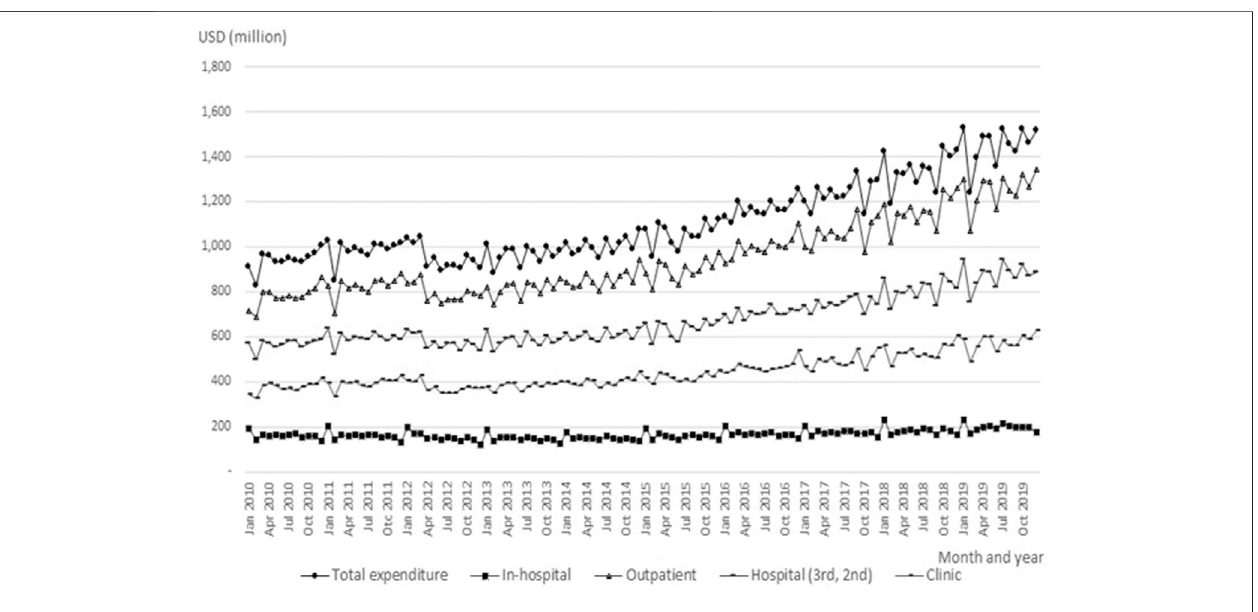
FIGURE 1 | Monthly pharmaceutical expenditures (total and by